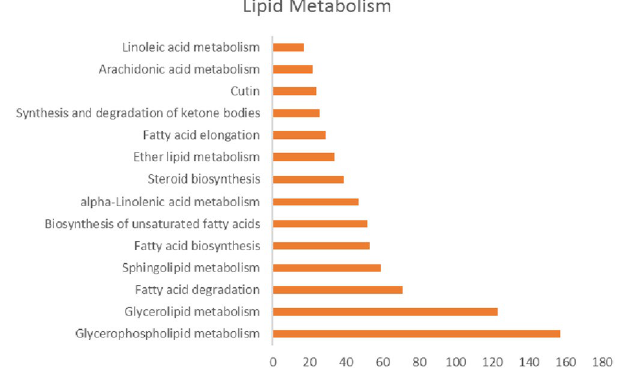
Figure 5. Lipid composition under heat